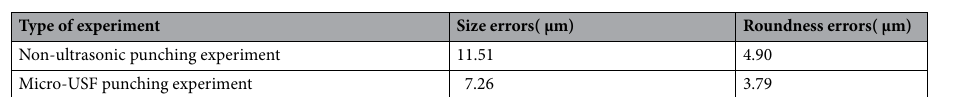
Figure 5. Scanning electron micrograph of the surface of the sample obtained from Micro-punching experiment. (a) Non-ultrasonic punching experiment. (b) Micro-USF punching experiment.